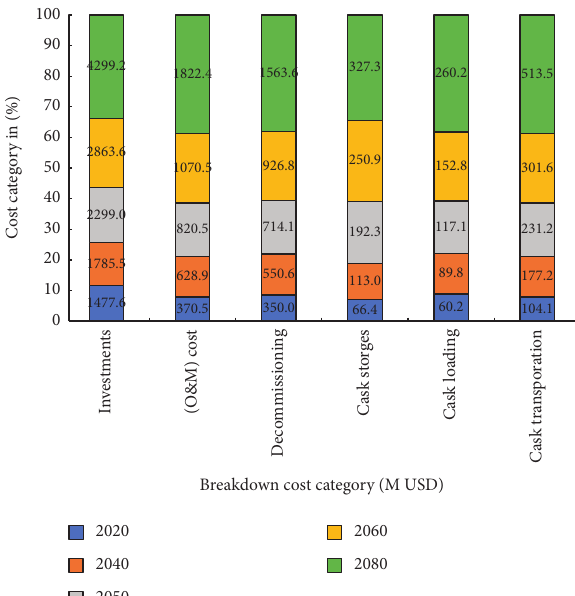
Figure 16: Breakdown of cost categories in % of total cost for facilities using concrete cask storages, for